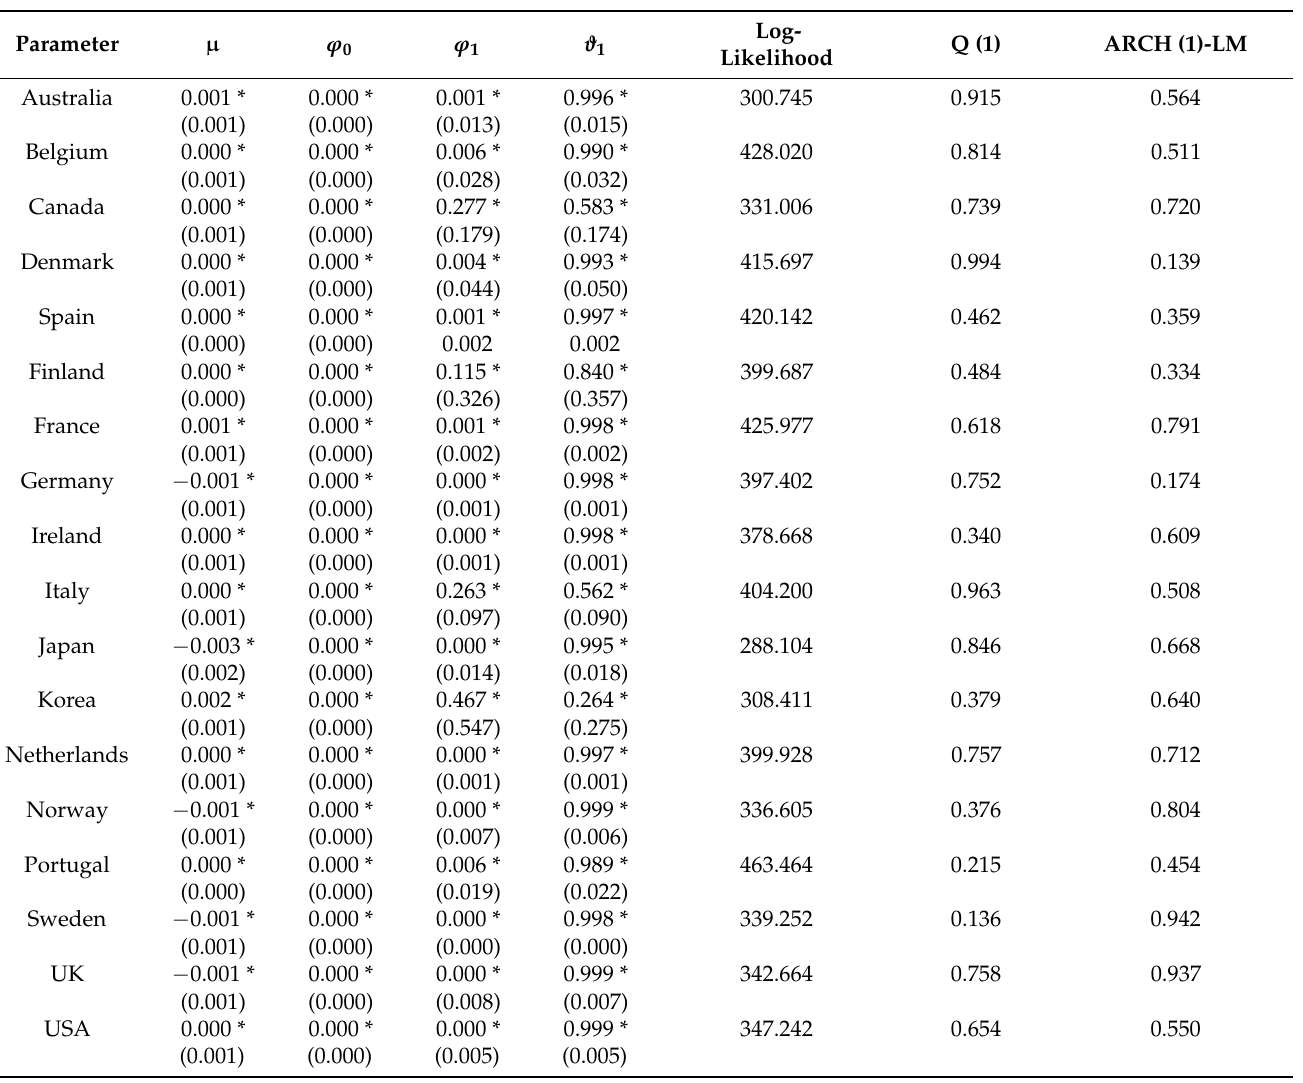
Table 7. The results of GARCH (1,1) for exchange